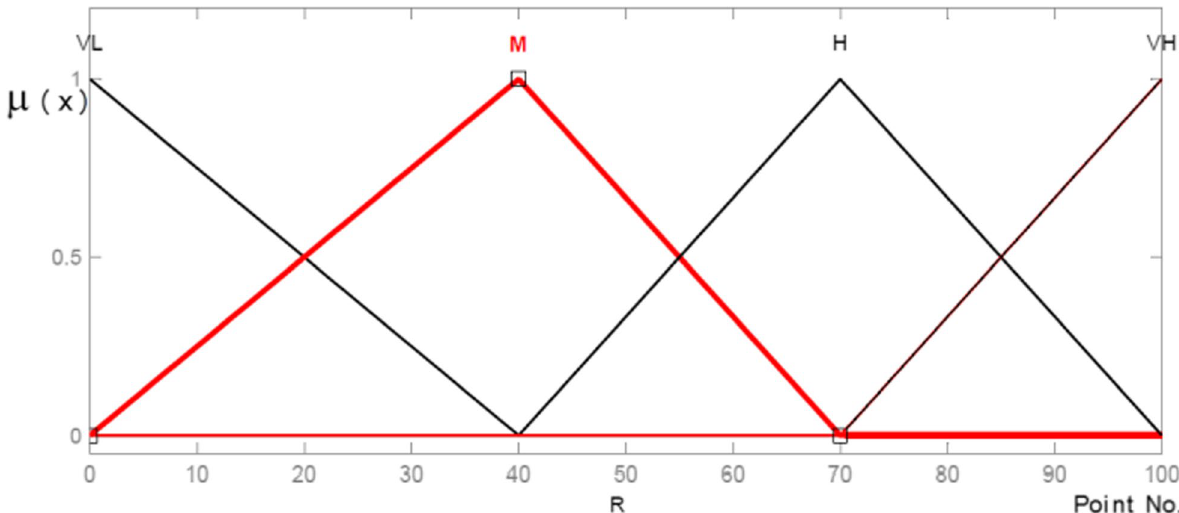
Fig. 5 Risk of damage of a linear